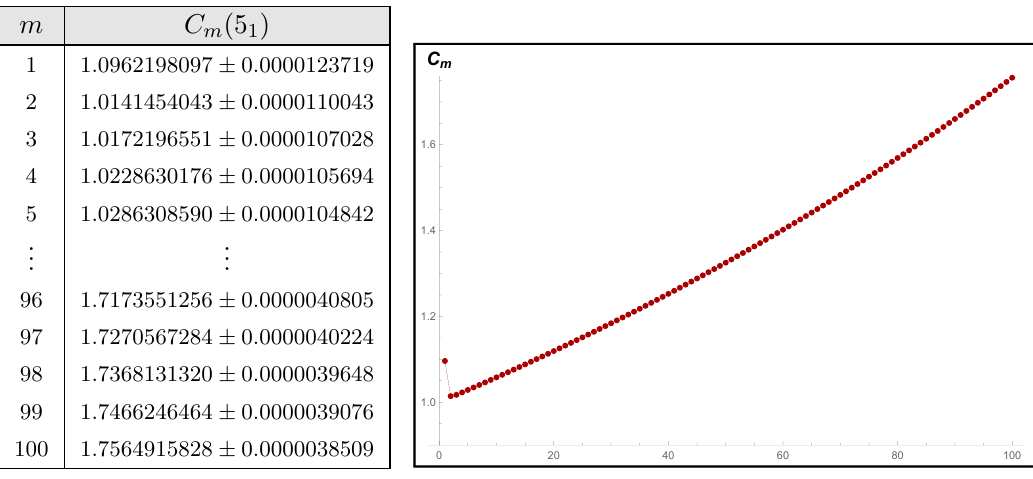
Table 3. The k → ∞ values of the Rényi entropies associated with the state | 3 1 # T 2 , 2 i .